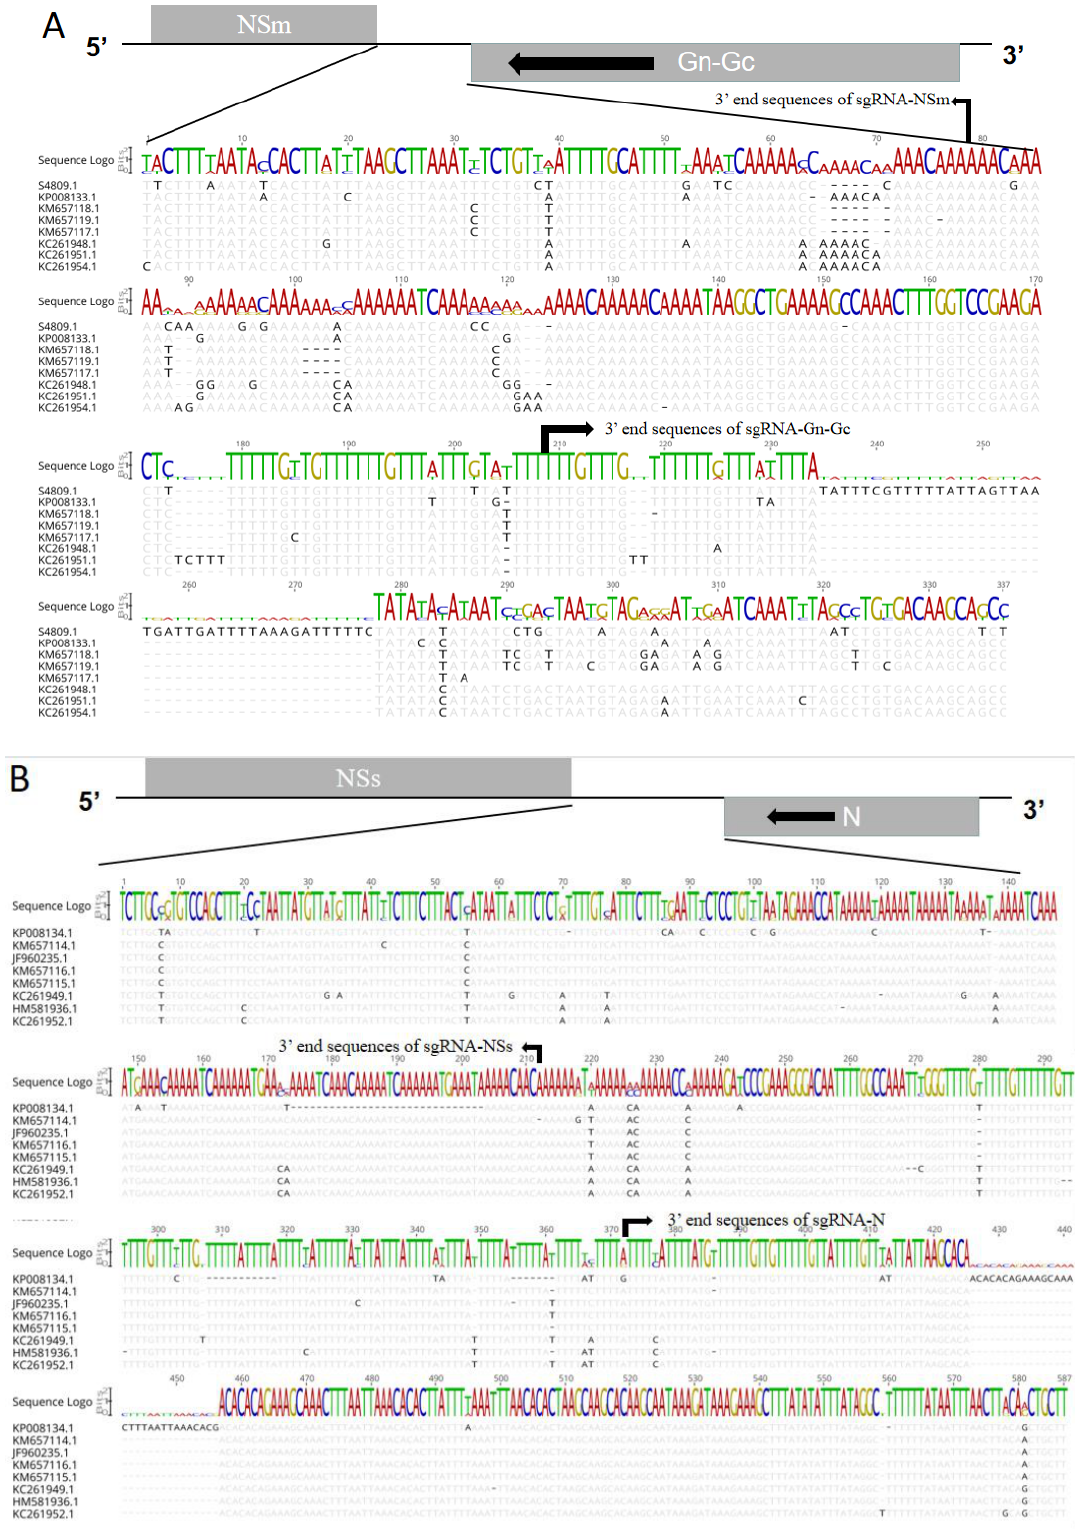
Figure 3. TSWV RNA M and S intergenic region (IGR) alignment. ( A ) Alignment of the nucleic acid sequences of IGR of RNA M . ( B ) Alignment of the nucleic acid sequences of IGR of RNA S . 2.4. Effect of 5′ and 3′ UTR of TSWV gRNA and sgRNA on Cap-Dependent or Cap-Independ- ent Translation To determine what role the 5 ′ and 3 ′ UTRs play in TSWV gRNA and sgRNA transla- tion, in vitro translation assays were performed using wheat germ extract (WGE). The